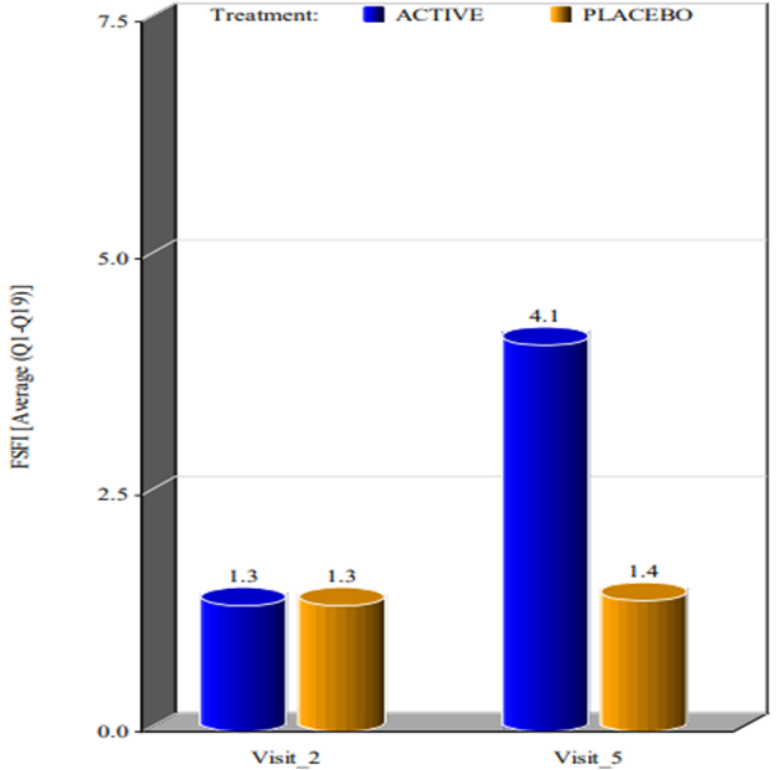
Figure 1. Mean value of FSFI considering the 19 questions at the first visit and at visit 4 weeks after the beginning of the treatment. (Visit 2 corresponds to the visit performed on day 0, as Visit 1 corresponds to the day of laboratory tests).